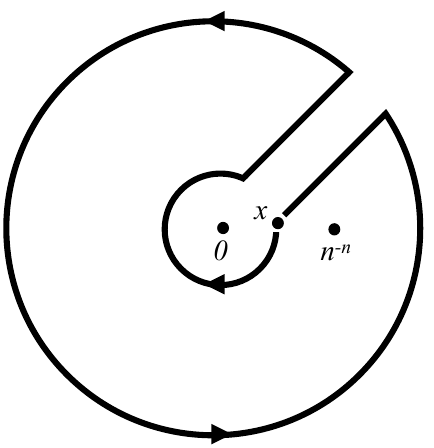
Figure 3 . Analytic continuation path for the non-trivial loop counterclockwise around the singu- larity at x = n (cid:0) n